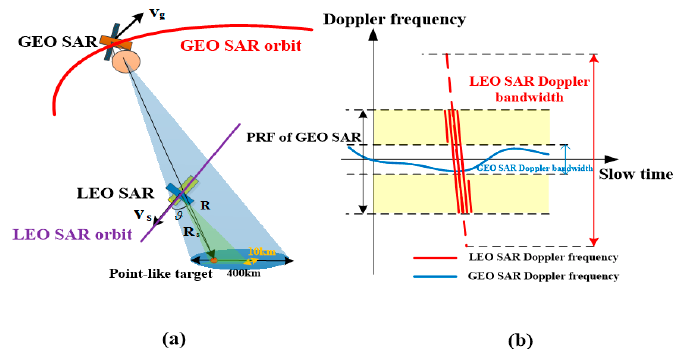
Figure 6. ( a ) Geometry relationship between LEO SAR and GEO SAR; ( b ) Doppler bandwidths of GEO SAR and LEO SAR.